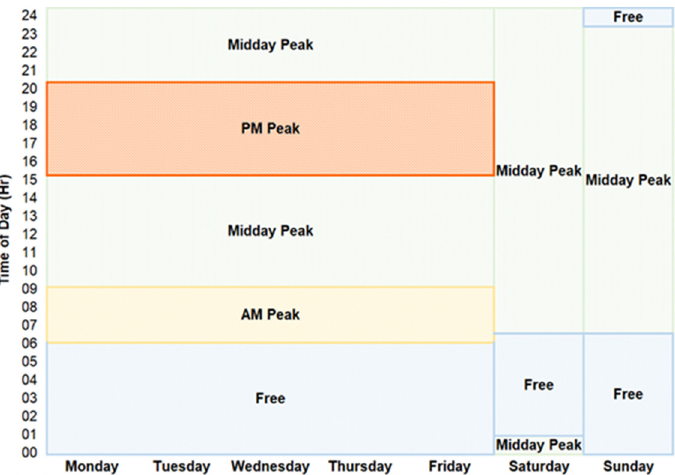
Figure 3. Currently deployed TOD signal timing plans.